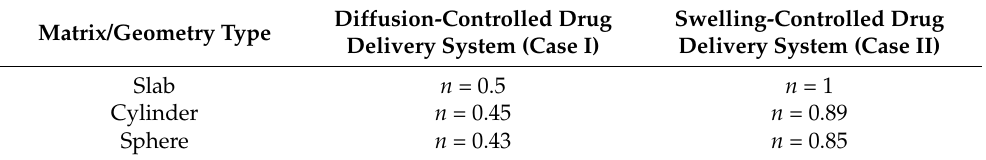
Table 1. Drug release exponent values ( n ) in the empirical power-law model proposed by Peppas et al., adapted from [97,104]. Reproduced from Lin et al. [97], with kind permission of the copyright holder, 2006, Elsevier; Reproduced from Siepmann and Pepaas [104] with kind permission of the copyright holder, 2001, Elsevier.